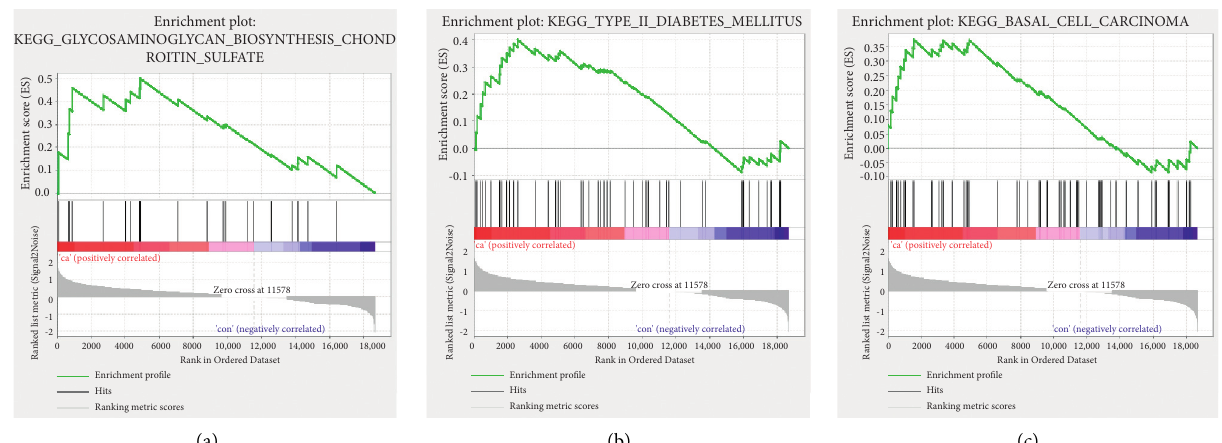
Figure 3: KEGG pathway related to exercise samples by GSEA analysis. (a) Glycosaminoglycan biosynthesis chondroitin sulfate. (b) Type II diabetes mellitus. (c) Basal cell carcinoma.